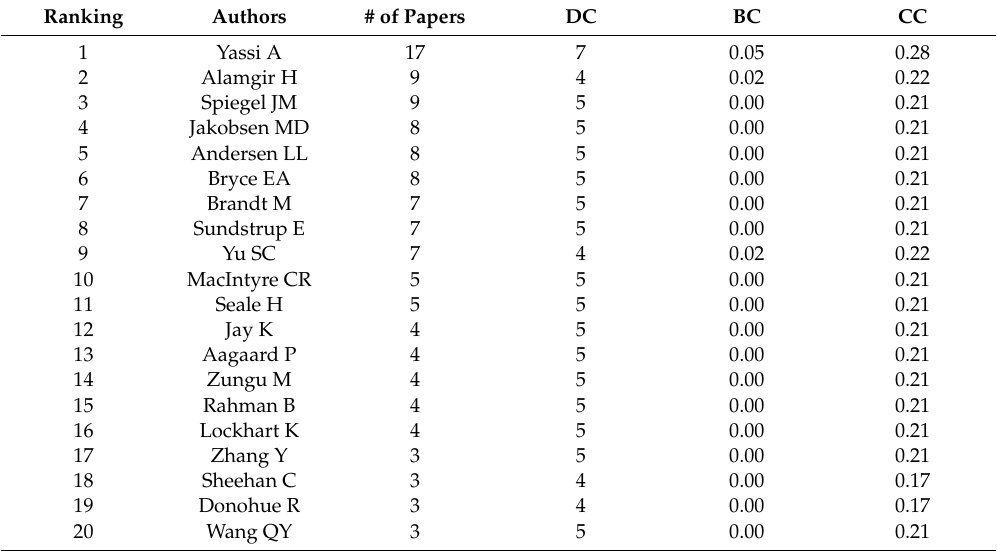
Table 2. Di ff erent centrality measures for top 20 most productive